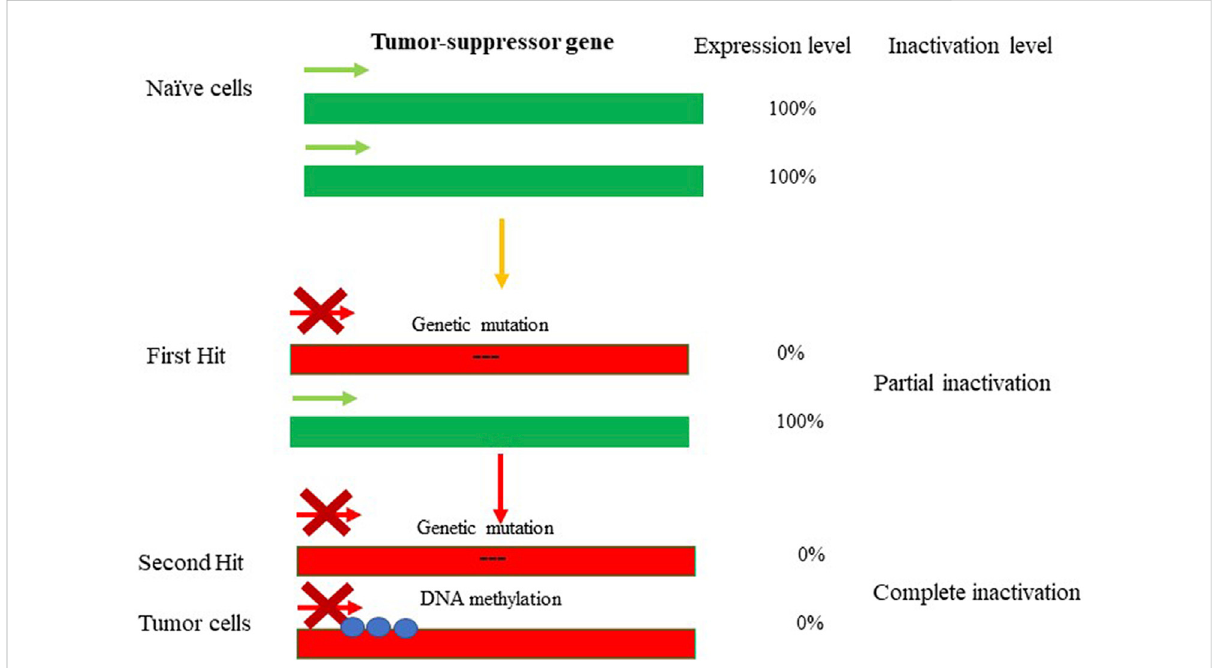
FIGURE 1 Genetic and epigenetic inactivation of tumor-suppressor genes (TSGs). Mutations lead to inactivation of one allele of tumor-suppressor gene resultinginpartialloss-of-function.The fi rsthithighlightstheeventleadingtopartiallossofgeneexpressionoftheTSG.Theselectionpressurethen could promote the second hit resulting in epugenetically-driven complete loss-of-function. The inactivity of TSG leads to